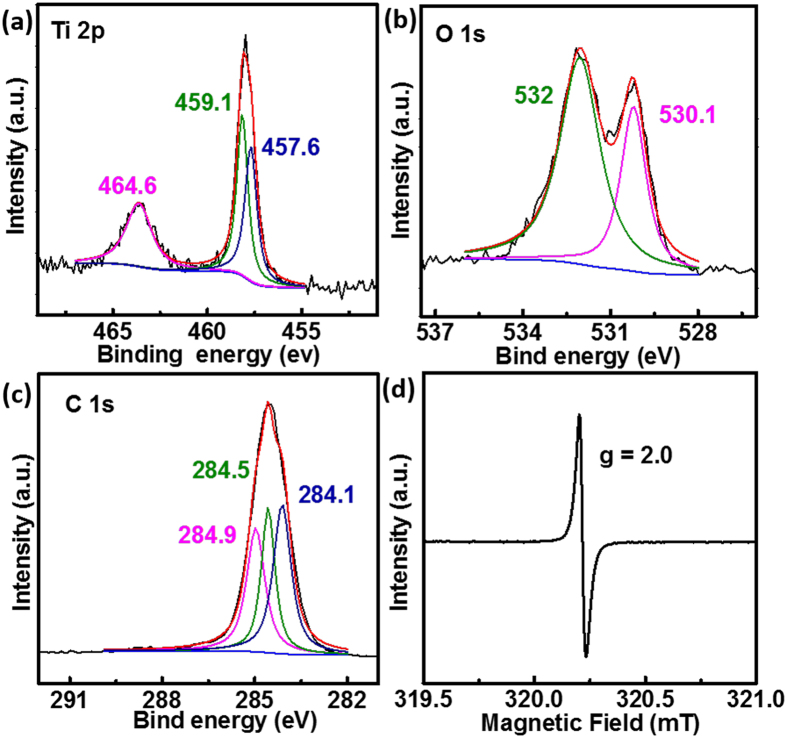
(a) Ti 2p, (b) O 1s, and (c) C 1s XPS spectra of rGO/TiO2-7ArH; (d) EPR spectrum of rGO/TiO2-7ArH collected at room temperature.